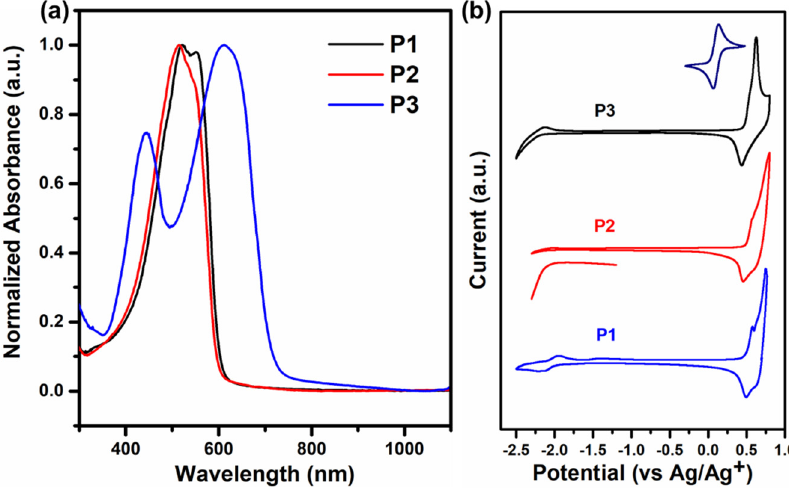
Figure 2. ( a ) UV–vis–NIR absorption spectra of non-doped P1 – P3 in film states. ( b ) Cyclic voltammograms of P1 – P3 in drop-casted films (the reduction peak of P2 is amplified separately).